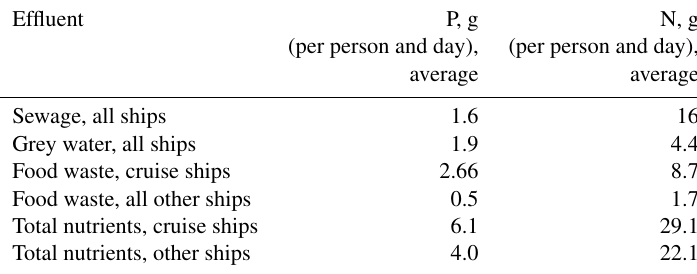
Table 6. Emission factors for nutrients used in the modelling. Effluent P, g N, g (per person and day), (per person and